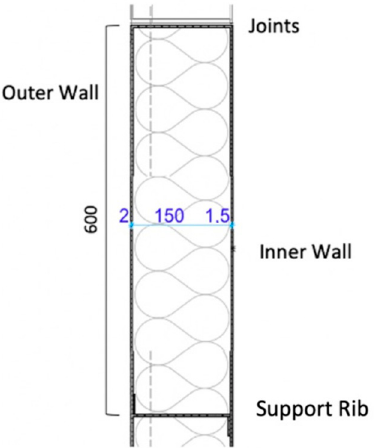
glass on the outer surface, 1.5 mm fiberglass on the inner surface, 3 mm fiberglass con- 150 mm, which is half the thickness of the roof panels. The internal vertical wall panels panels have 1.5 mm fiberglass surfaces and a core of 100 mm of stone wool. have 1.5 mm fiberglass surfaces and a core of 100 mm of stone wool.